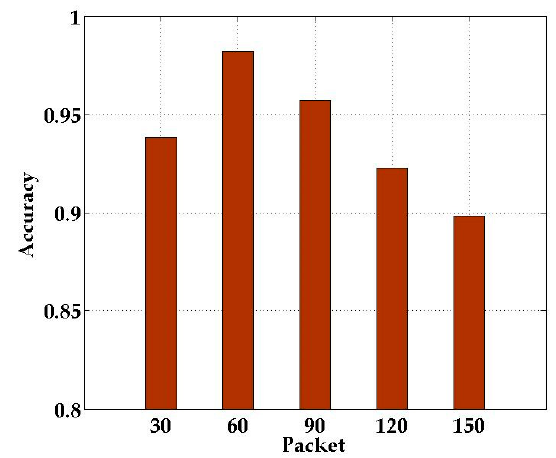
Figure 9. Comparison of data packet in different numbers.